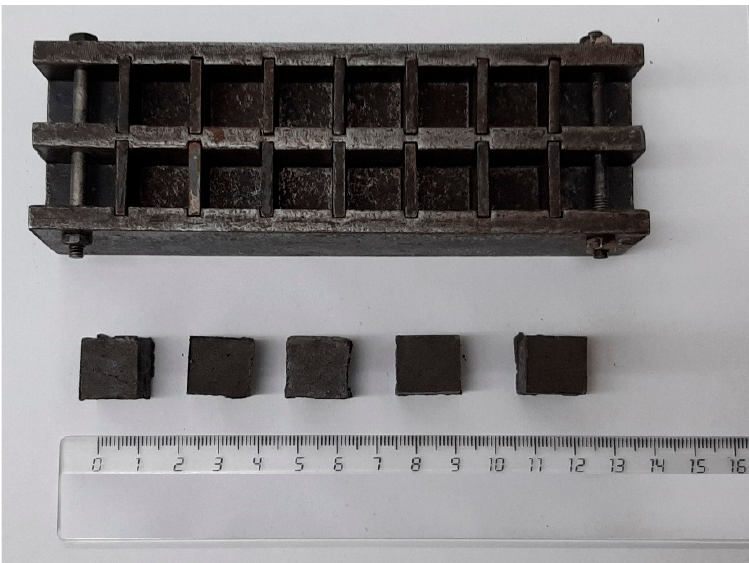
Figure 4. The appearance of geopolymer specimens and molds. Table 2. Composition of mixtures used for preparation of